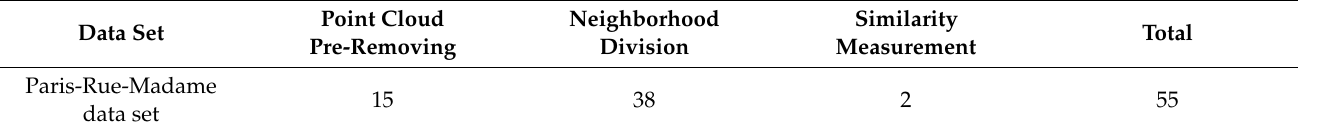
Table 4. Computing time (minute).